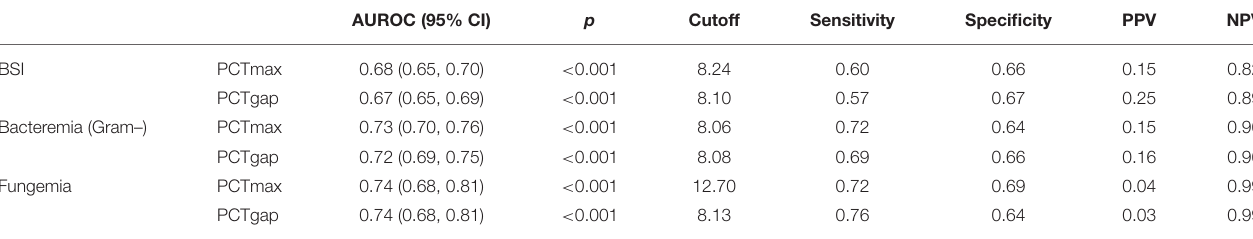
TABLE 2 | Receiver operating characteristic curve analysis to determine the optimum cutoff value of the PCT (ng/ml) for the prediction of